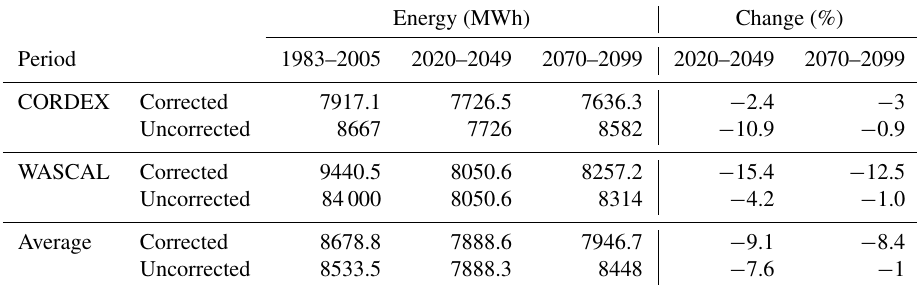
Table 4. Annual average projected energy